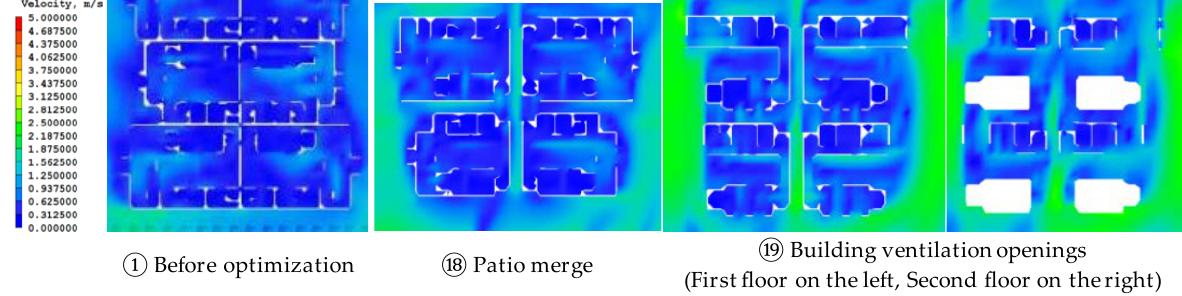
Figure 13. Comparison of simulation for optimization of building ventilation